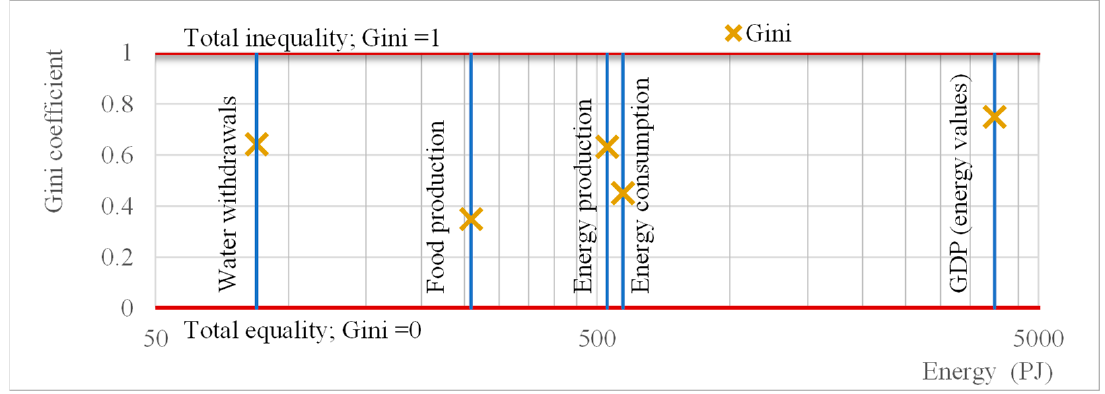
Figure 11. Gini coe ffi cient vs. the total available resources and money in energy units. Figure 11. Gini coefficient vs. the total available resources and money in energy